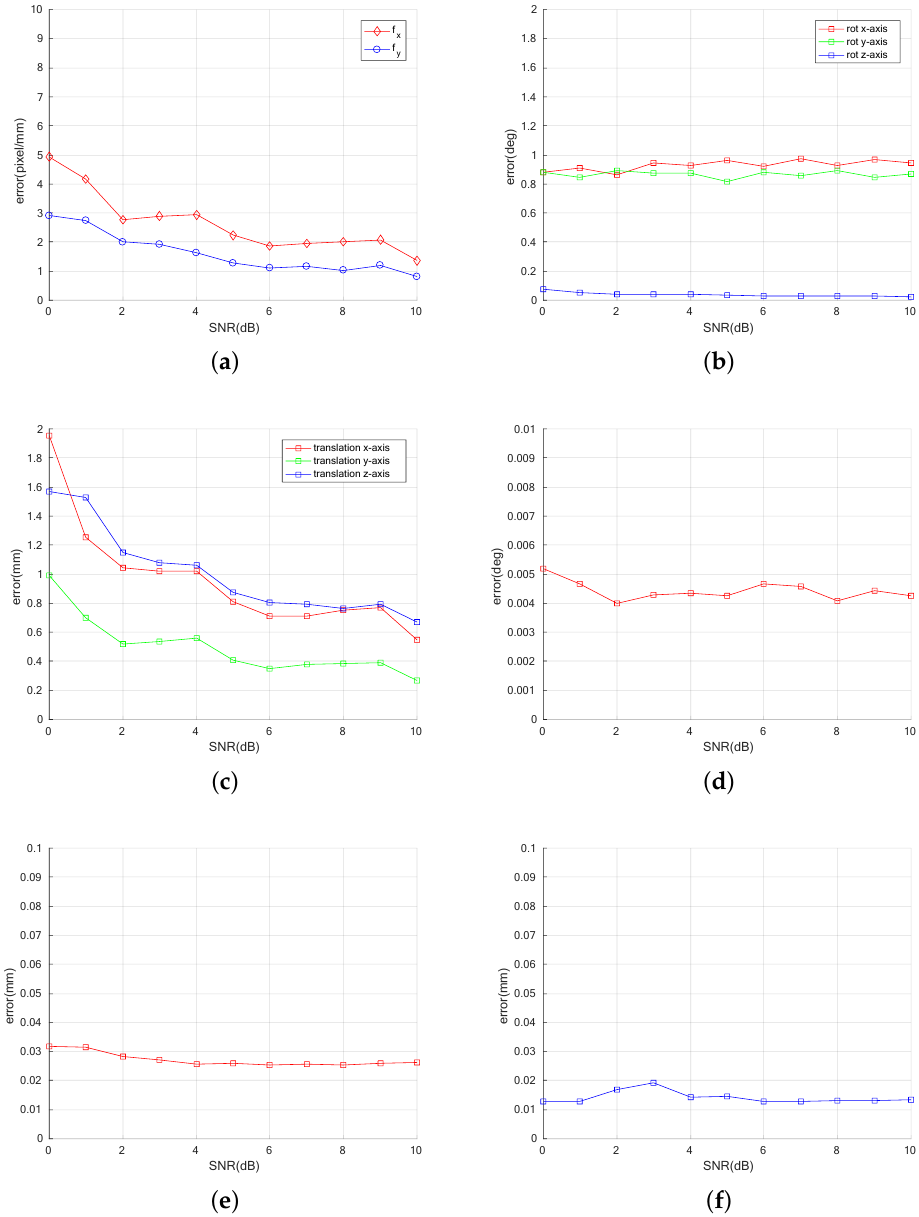
Figure 9. Mean absolute error for parameter estimation in noisy settings: ( a ) focal length f x , f y of the onboard camera; ( b ) rotational error r x , r y , r z ; ( c ) translational error t x , t y , t z of the pose; ( d ) angle error θ ; ( e ) gap error τ ; and ( f ) offset error (cid:101) of the optical